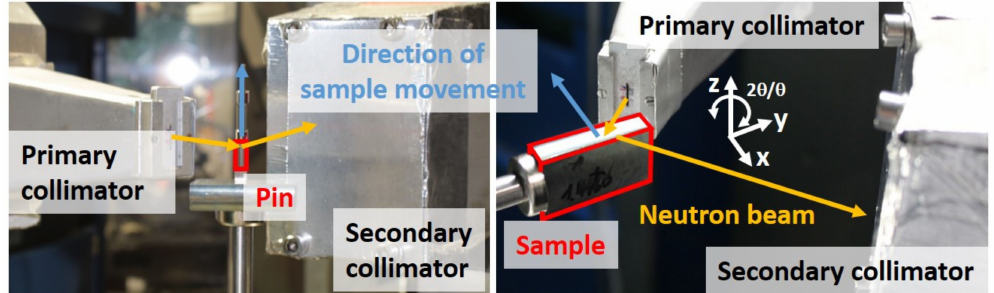
Figure 4. Principle measurement setup. Left: Z-mode for reference sample measurement. Right: Measurement of the bulk sample in the rolling